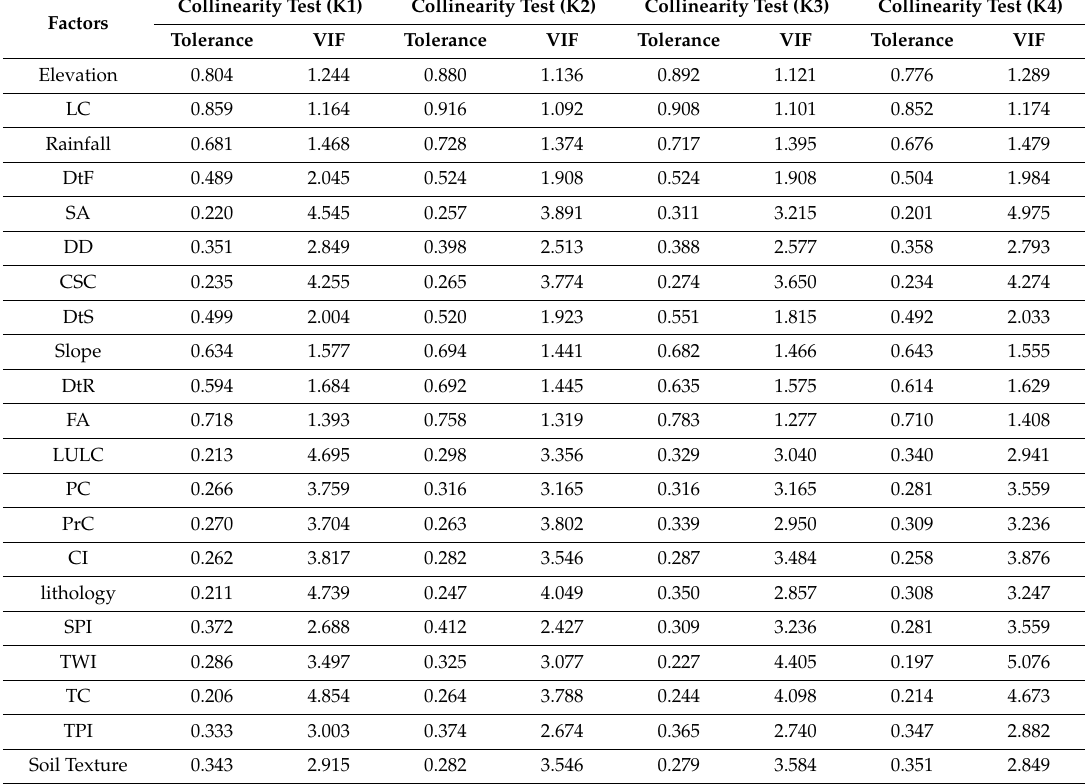
Table 1. Multi-collinearity test among